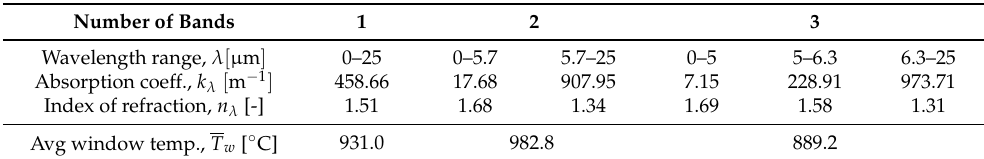
Table 3. Average window temperature for the reference glass obtained with different number of spectral bands for the radiative